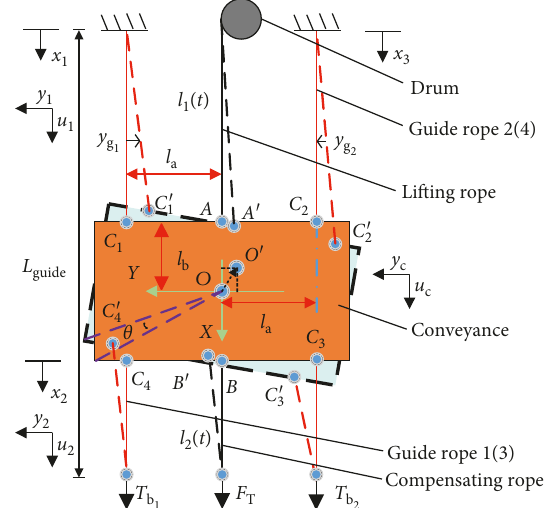
Figure 1: Traction system with tension acting on the compensating